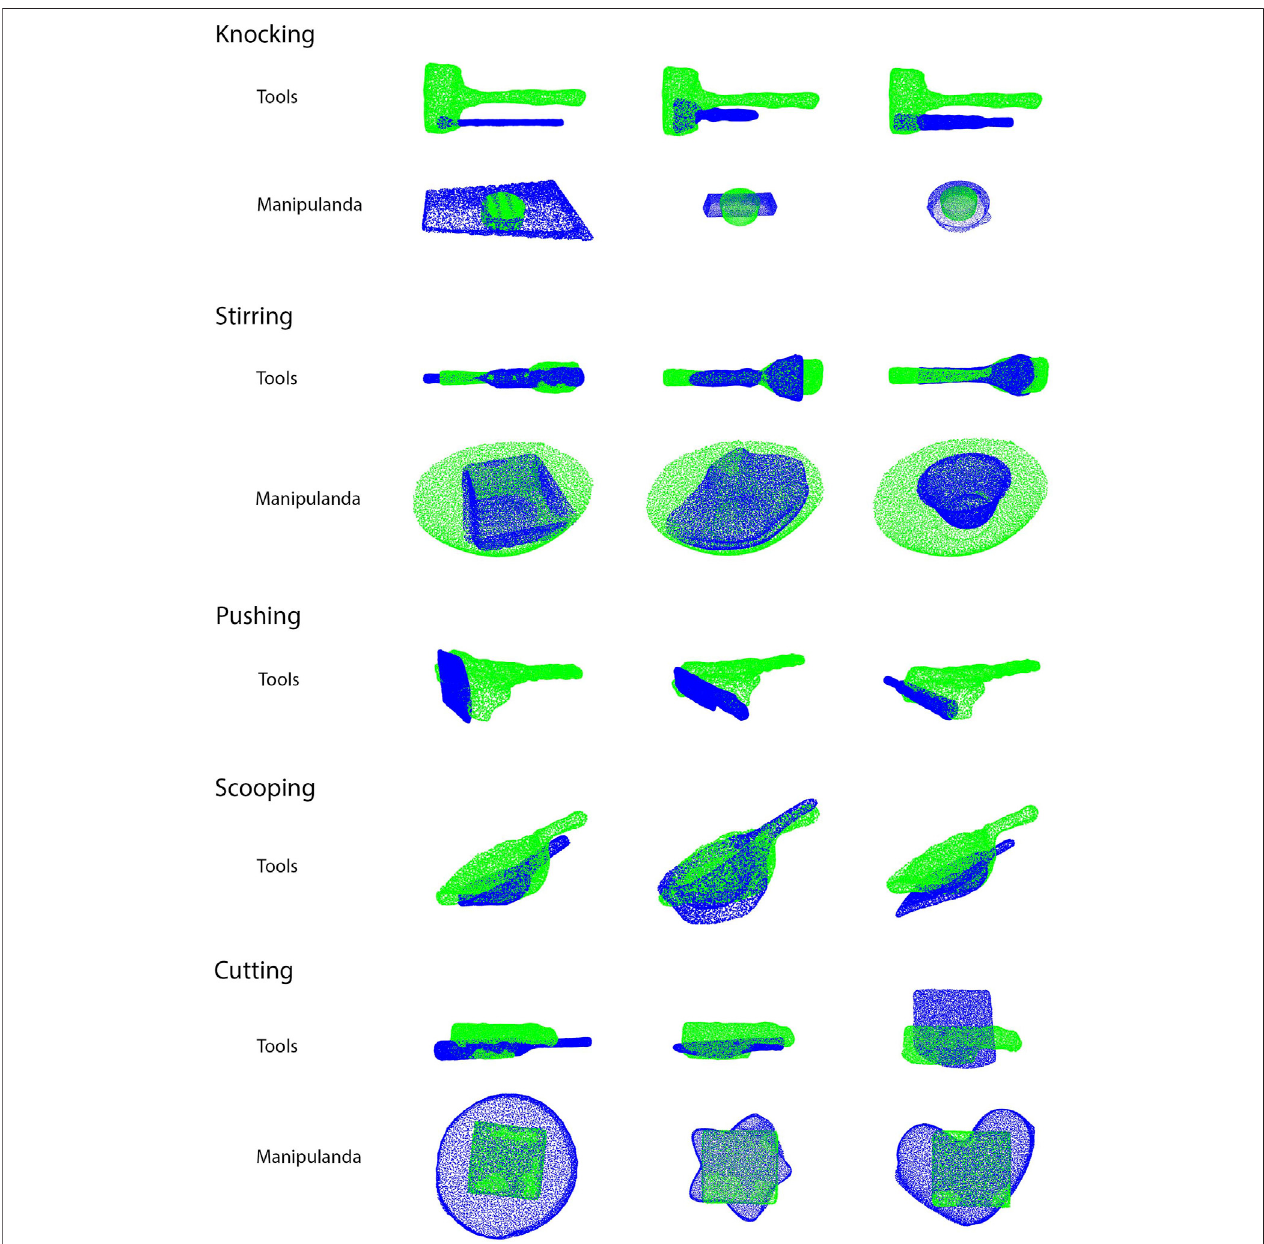
FIGURE 9 | Results of mapping substitute objects to source objects (Star 2). The green point clouds are the source objects while the blue point clouds are the substitute objects. Manipulandum substitution for the pushing and scooping task is not geometry-dependent, but goal-dependent, and therefore, the mapping results are excluded in the fi